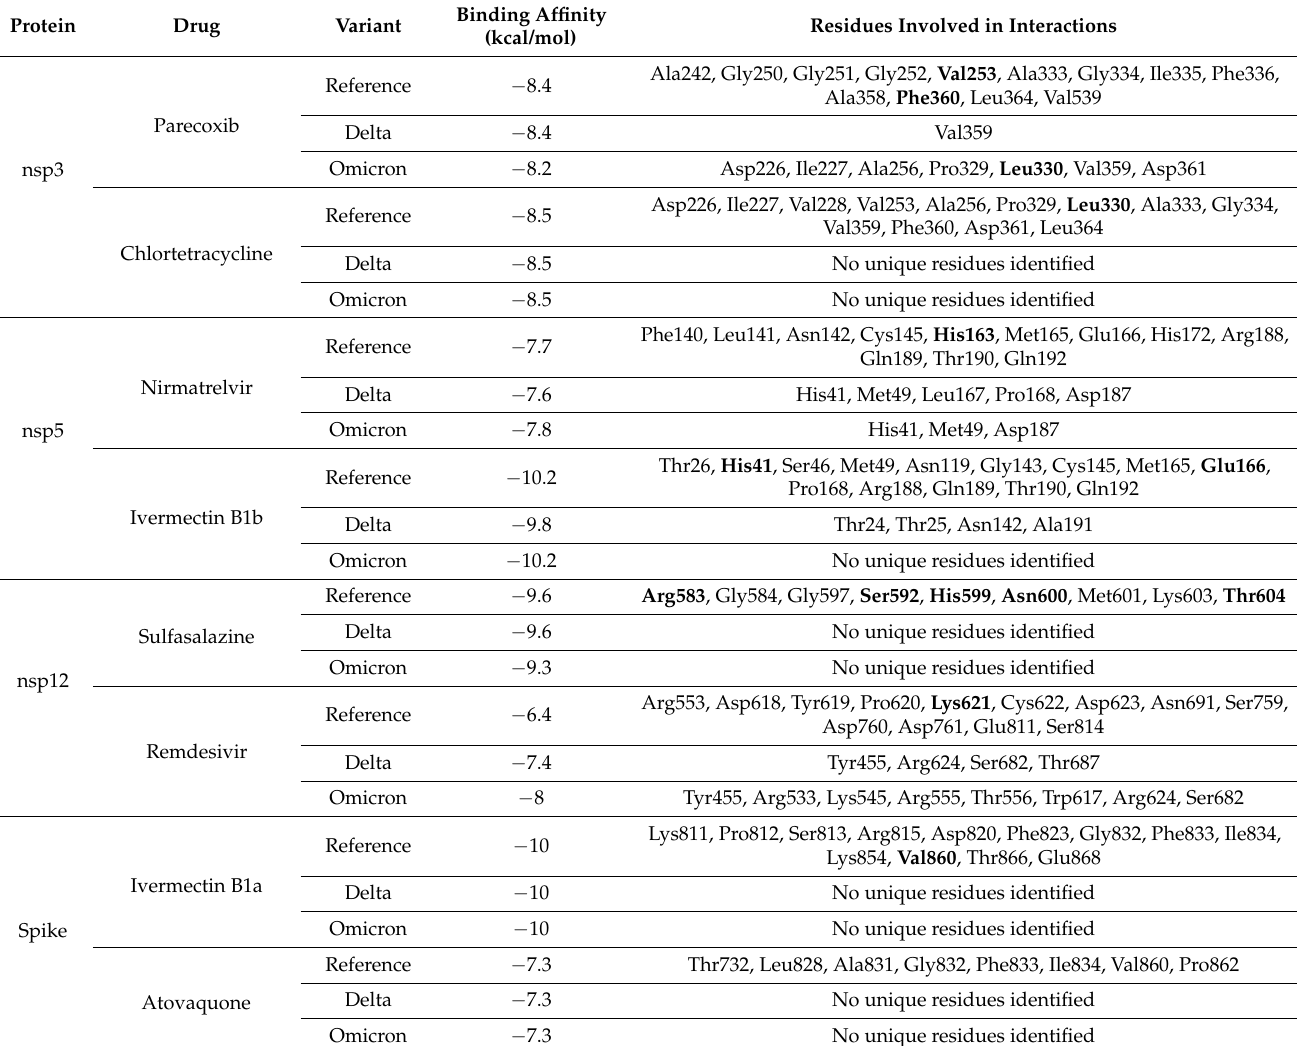
Table 1. Molecular docking analysis of eight antiviral compounds (parecoxib, chlortetracycline, ivermectin B1a, ivermectin B1b, sulfasalazine, remdesivir, atovaquone, and nirmatrelvir) against